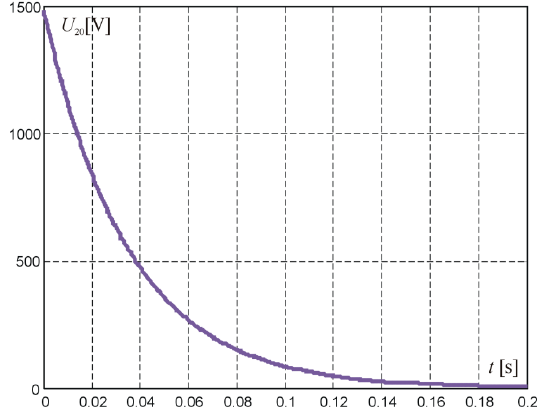
Figure 4. Voltage curve at the output of the two ‐ port network.